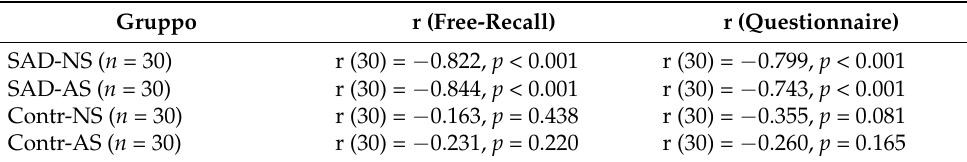
Table 2. Correlational analysis between GSS scores and free-recall and recognition memory scores for the four different